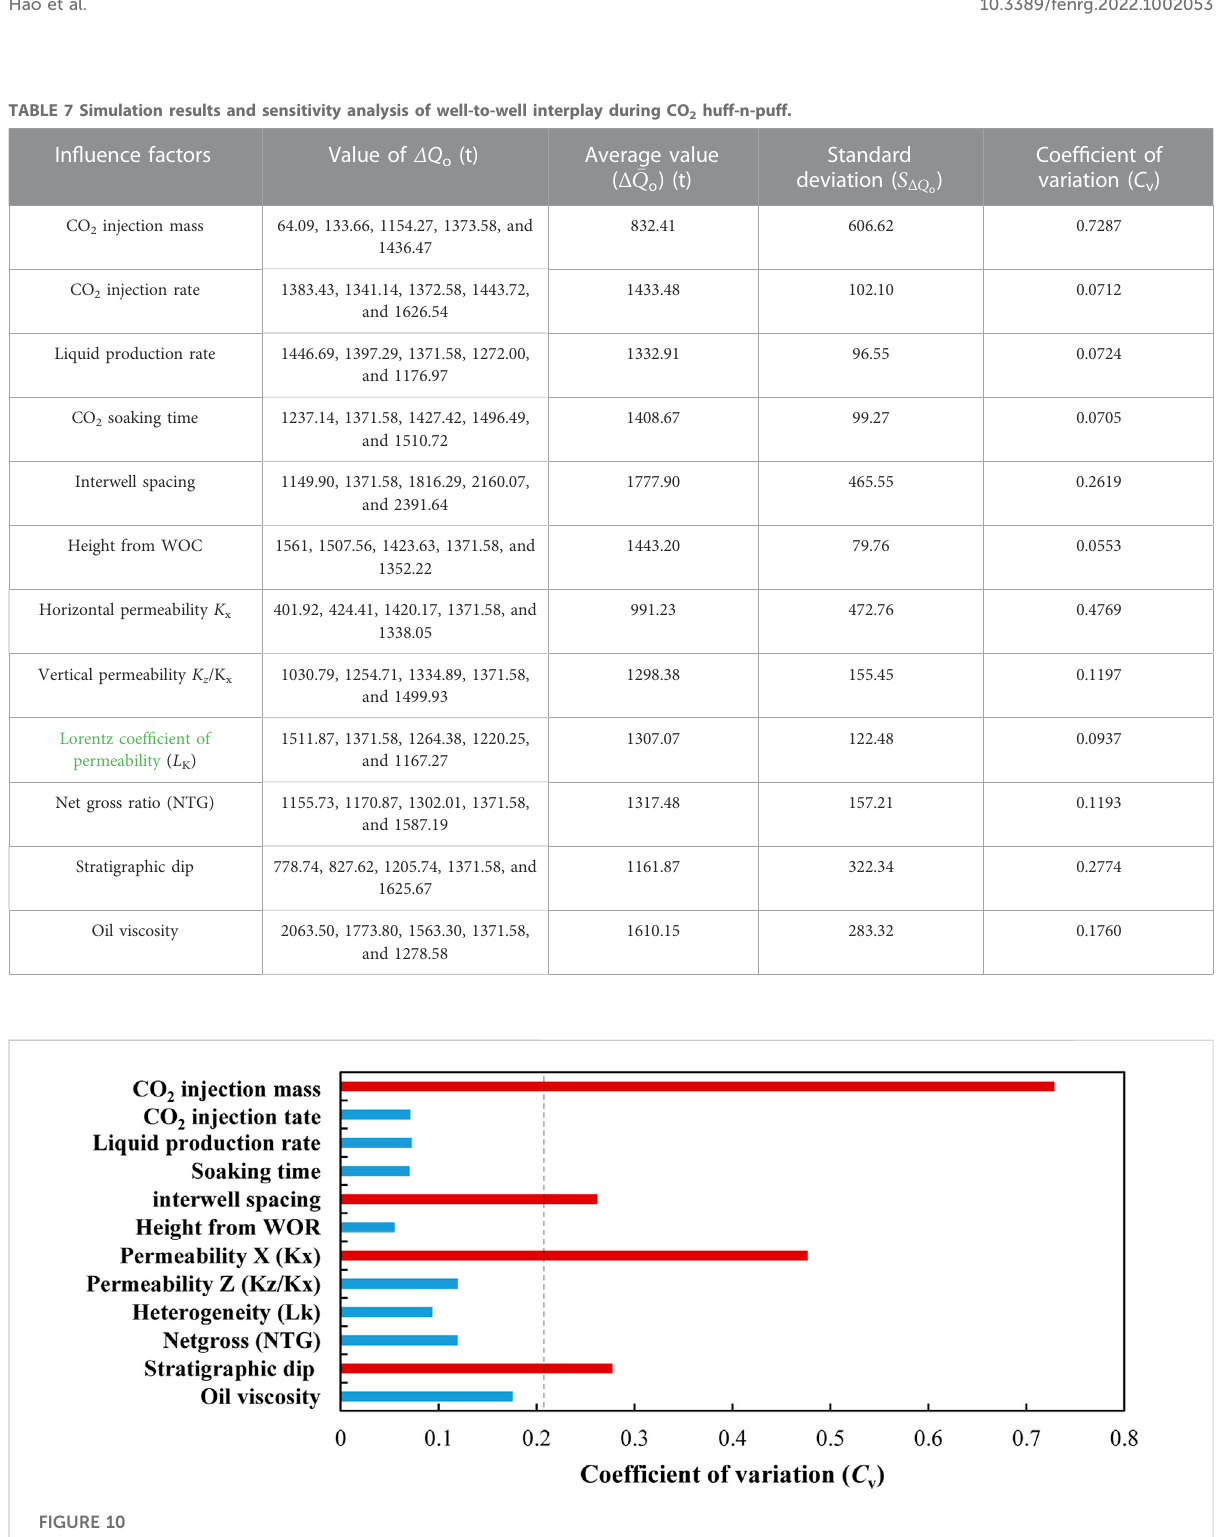
Frontiers in Energy